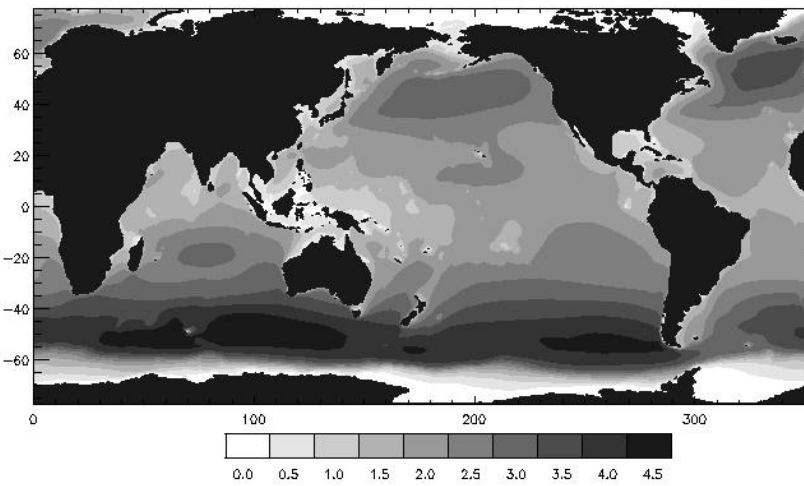
Figure 2. Average annual significant wave height (m).